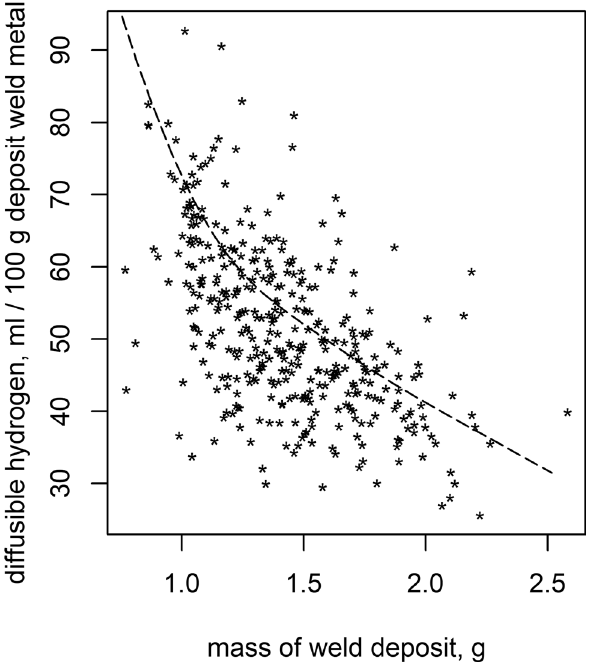
Fig. 6 Correlation between diffusible Hydrogen H deposited weld material m